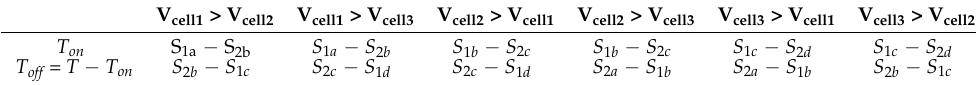
Table 1. Actions of the controlled semiconductors, S xy